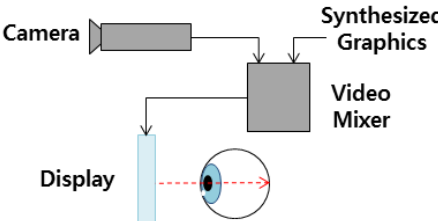
Figure 3. Schematic diagram of a video see-through